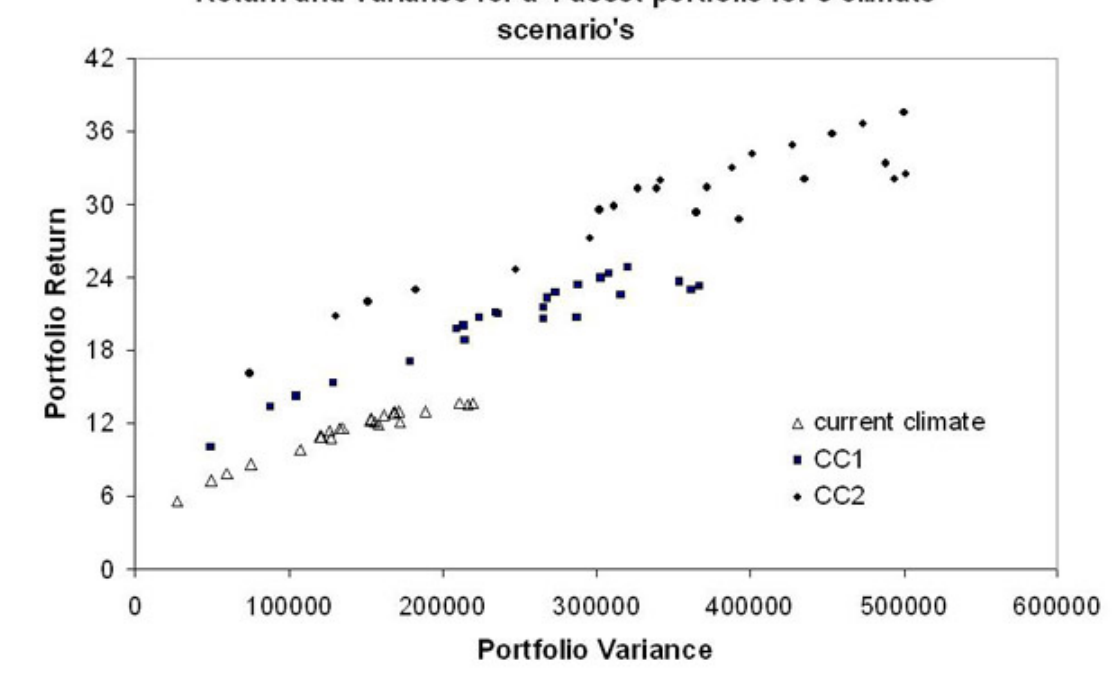
Fig. 7. Portfolio return and variance values for portfolios consisting of four assets under the current, CC1 and CC2 climate